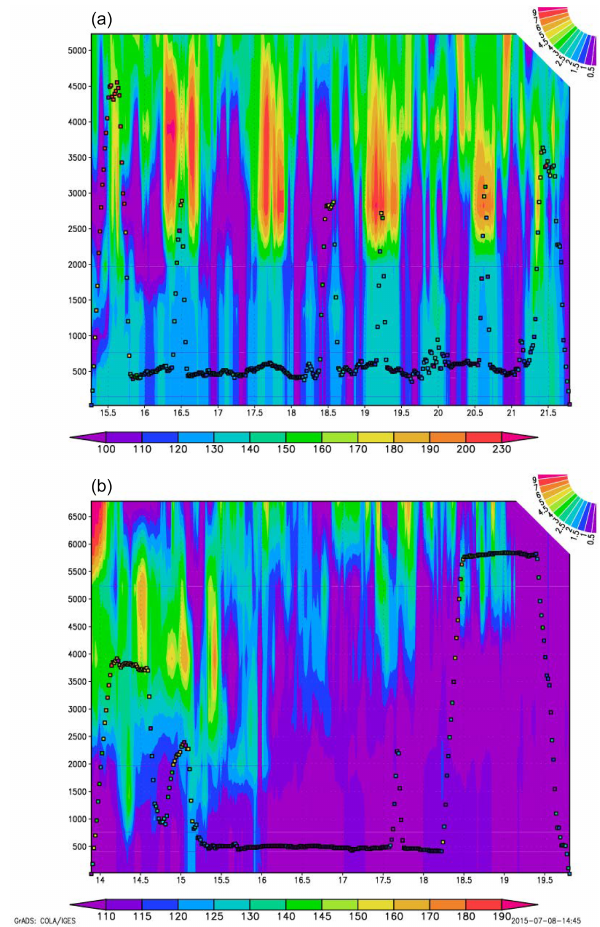
Figure 8. Vertical distributions of CMAQ-simulated (cid:49) CO (ppb) shown along a flight transect on (a) 16 June 2013 and (b) 10 July 2013; the x -axis label is UTC (hour) and y -axis label is meters a.g.l. Two color bars represent observed CH 3 CN concen- tration (filled square dots and rectangle bar in ppt) and simulated (cid:49) CO concentration (backdrop color shading and fan bar in ppb),